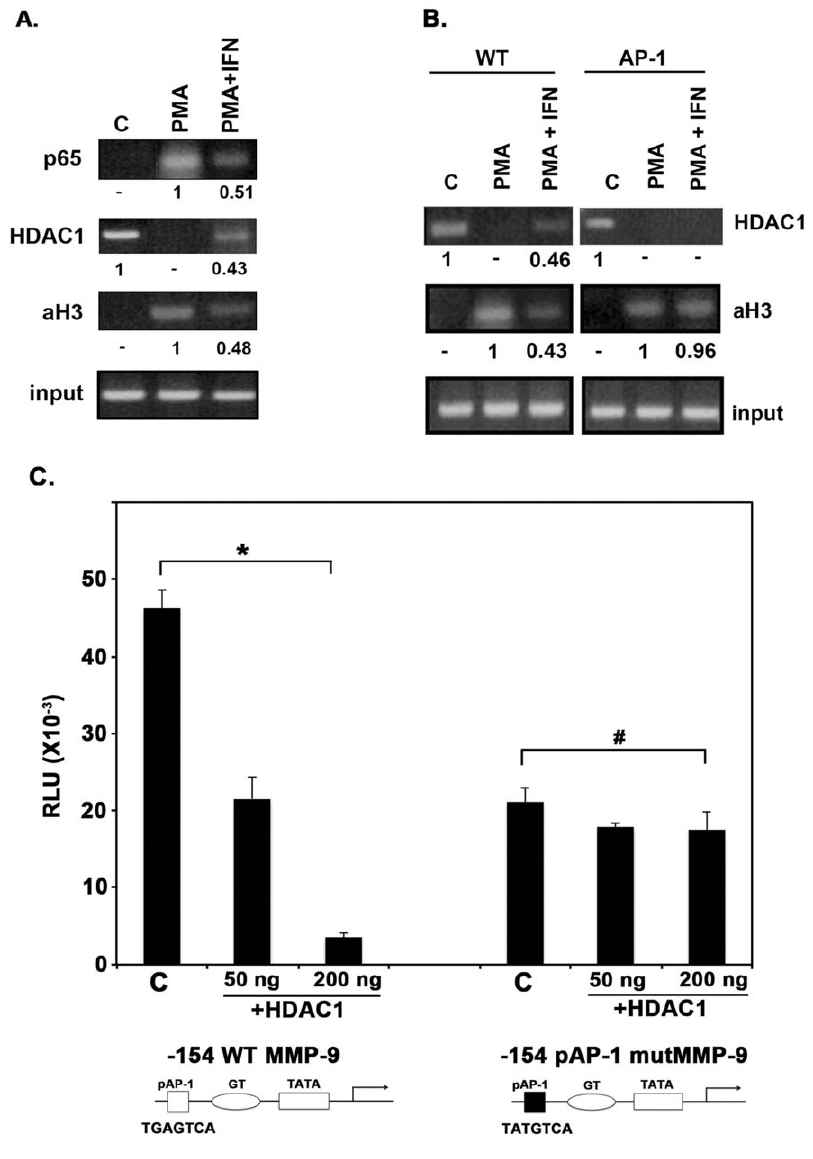
Figure 4. Chromatin Immunoprecipitation (ChIP) analysis of the MMP-9 promoter. (A) HDAC1 recruitment on MMP-9 promoter in response to IFN b . HT1080 cells were treated with IFN b for 12 hrs, PMA for 4 hrs, or both. ChIP assays, using antibodies specific to p65, histone deacetylase (HDAC)-1, or acetylated histone-3 (aH3) were performed, followed by PCR performed within the linear range of amplification (determined to be 38 cycles). Input chromatin (1%) was removed from samples prior to immunoprecipitation and subjected to PCR to control for any variation in starting material. Band intensities were normalized to input and the relative band intensities were calculated. The relative band intensities are shown under each band with respect to the strongest band being represented as 1. Data shown is representative of four independent experiments. (B) HDAC1 recruitment on MMP-9 promoter in response to IFN b is prevented in vivo by rendering AP-1 site non-functional. HT1080 cells were stably transfected with 2 660 bp MMP-9 promoter luciferase reporter constructs, either with or without proximal AP-1 site mutated. Resulting stable lines were treated with IFN b for 12 hrs, PMA for 4 hrs, or both. Chromatin immunoprecipitation (ChIP) assays, using antibodies specific to histone deacetylase (HDAC)-1, or acetylated histone-3 (aH3) were performed, followed by PCR. PCR primers were designed to include the region of interest of the MMP-9 promoter and a section of the luciferase reporter, to select against amplification of endogenous wild type MMP-9 promoter region. Band intensities were normalized to input and the relative band intensities were calculated. The relative band intensities are shown under each band with respect to the strongest band being represented as 1. Data shown is representative of three independent experiments. (C) AP-1 binding to the proximal site is required for HDAC1 induced repression of MMP-9 HT1080 cells were co-transfected in 6-well dishes in triplicates with either 2 154 MMP-9 promoter deletion construct containing a point mutation in the proximal AP-1 site, which renders the binding site non-functional, or with wild type 2 154 MMP-9 construct and varying amounts of a HDAC1 expression construct. Cell extracts were assayed for firefly luciferase activities, and normalized by protein concentration to account for any cell concentration differences between samples. P-values were calculated using statistical analysis software. As indicated above the bars, * indicates P-values of significance (50 ng = 0.000698 and 100 ng = 0.000885, significant difference) and # indicates P-values of no significance (50 ng = 0.0763 and 100 ng = 0.882, no significant difference) with significant values being ,